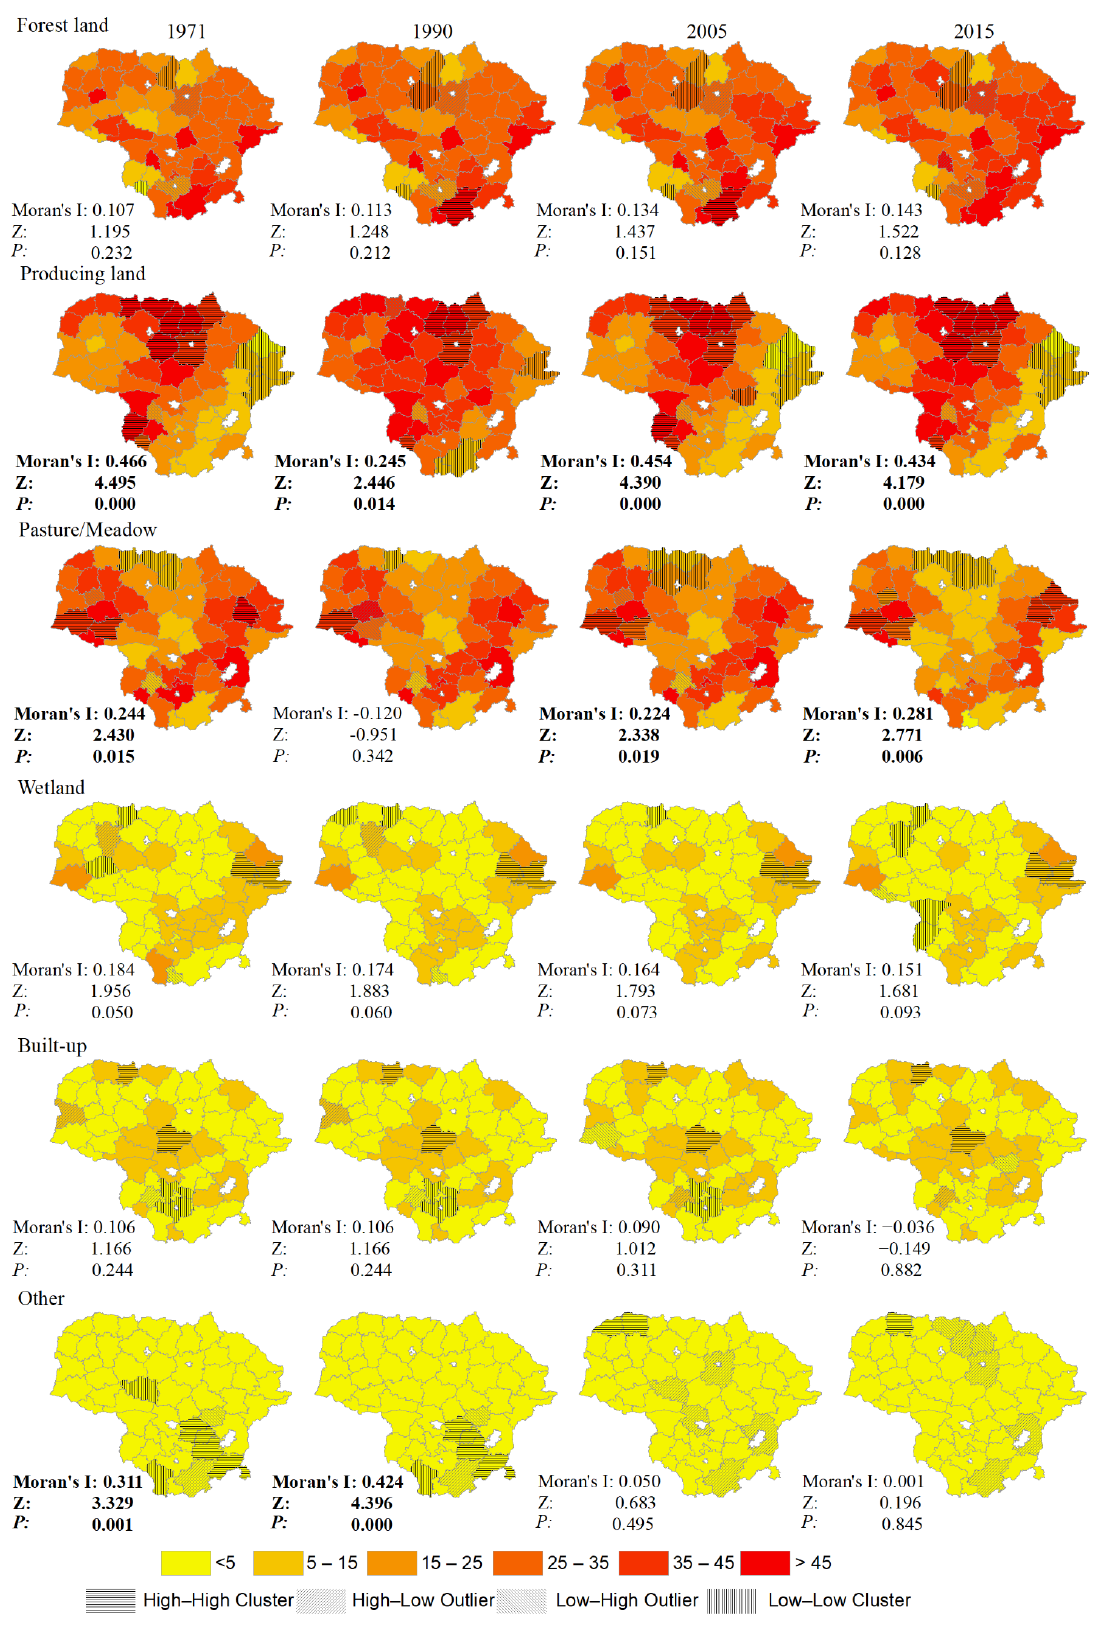
Figure 3. Area proportions of land-use types in Lithuanian municipalities during different periods since 1971. Statistically significant values of Global Moran’s I statistic are in bold. Linear shades identify statistically significant hotspots, cold spots, and spatial outliers based on the Anselin Local Moran’s I